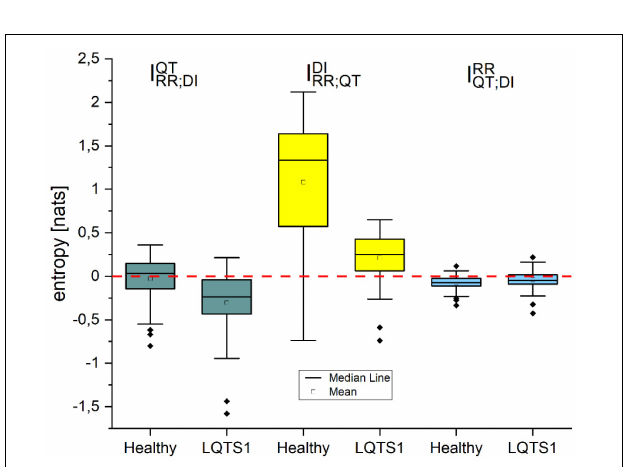
FIGURE 11 | Conditional transfer entropy difference for the information flow between heart rhythm (RR intervals) and the diastolic intervals given the repolarization (QT intervals) for healthy individuals and for LQTS1 patients. The Kolmogorov–Smirnov test was used, p -value = 0.002.